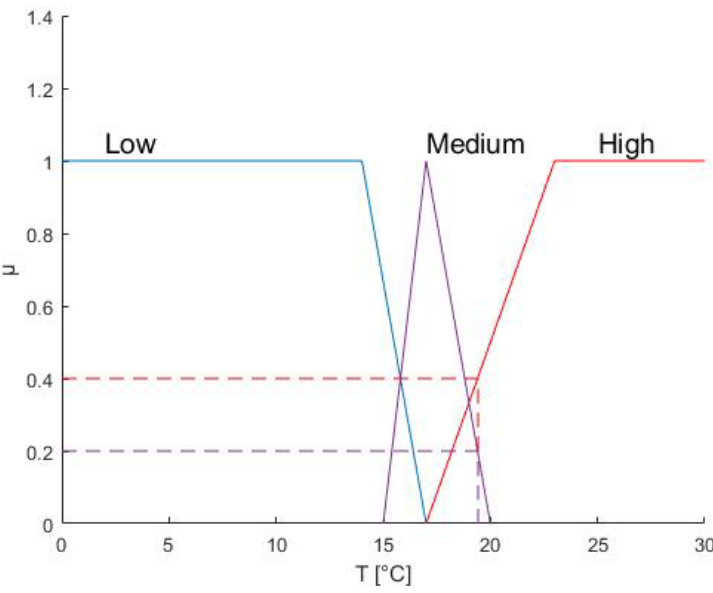
Figure 2. Temperature domain divided into three fuzzy sets. The dash lines help to take information about the µ value in the three fuzzy sets at a specific temperature.